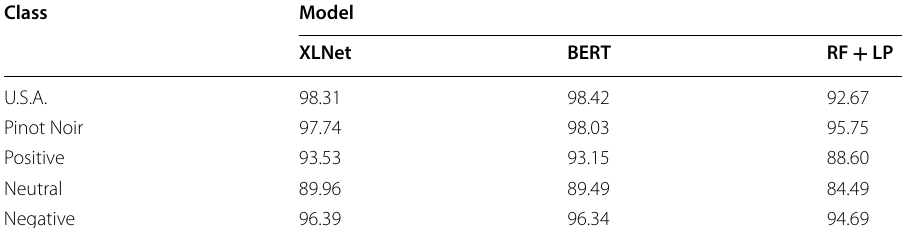
Table 12 Class based accuracy of the top-five classes in the WE dataset Class Model